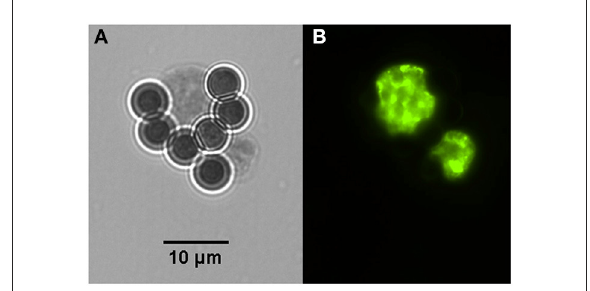
FIGURE2 Two i n vitro produced tissue cysts of Toxoplasma gondii bound to magnetic beads containing the monoclonal antibody K8/15-15. (A) One of the cysts has about the size of the magnetic bead, which has 4.5 µ m in diameter. (B) Bradyzoites inside the captured cysts were labeled by immunofluorescence using a rabbit serum to the bradyzoite antigen